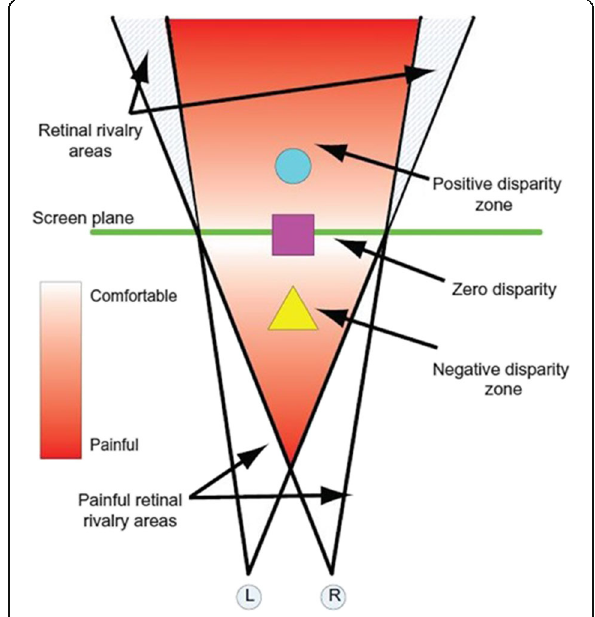
Fig. 2 Stereo comfort zone based on human stereo vision